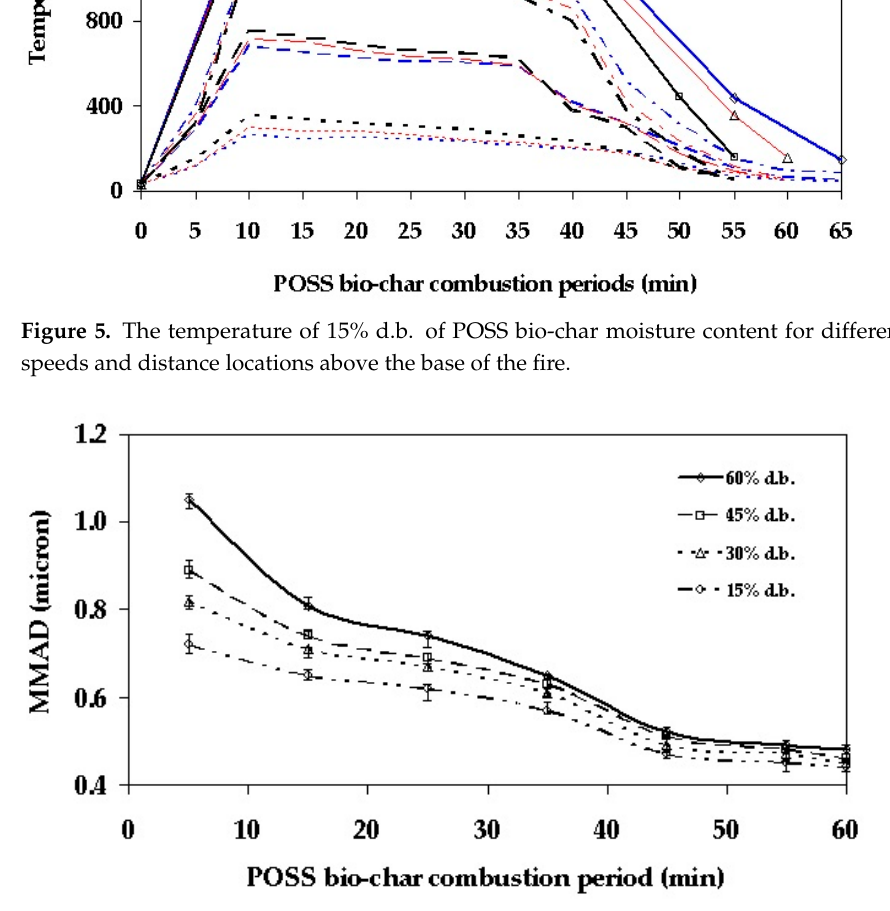
Figure 7. Total particle mass concentration emission from the POSS bio-char combustion for differ- ent moisture contents.